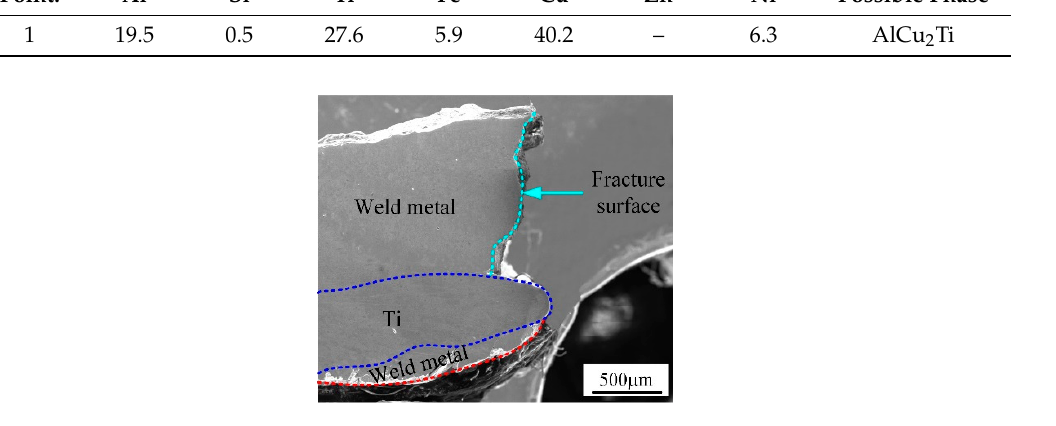
Figure 12. Fracture side of joint I.